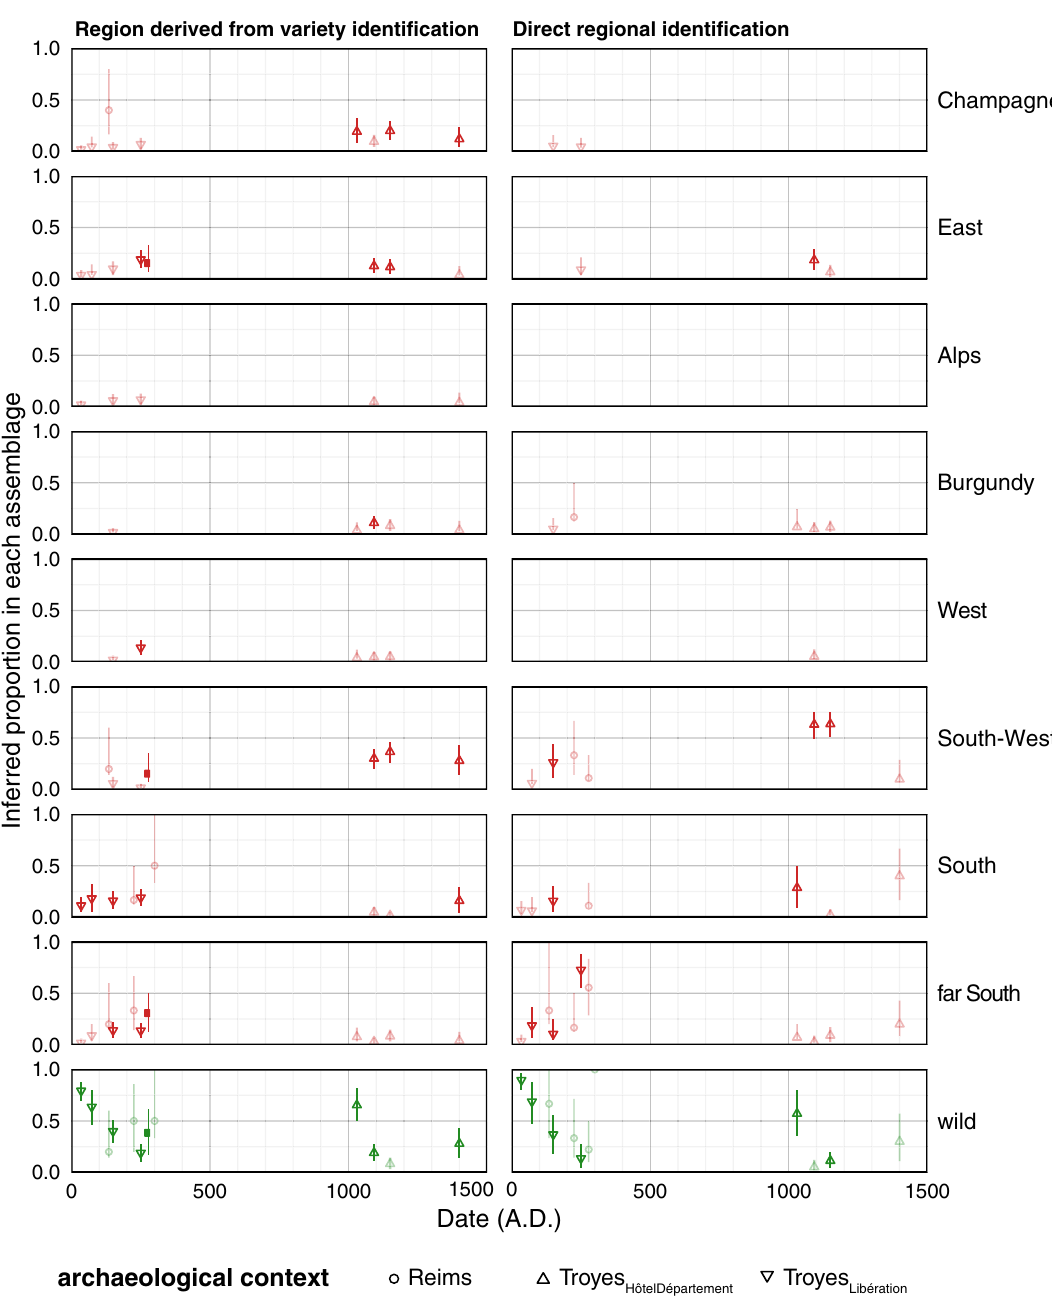
Figure 6. Dynamics of regional origins in each phase. The two columns report regional origins obtained through LDA cépage and LDA region ; rows report proportion of geographical groups calculated within each phase. Symbols represent sites, confidence intervals were obtained through 10 3 permutations, colors report identification obtained with LDA status , all are faded when sample sizes are